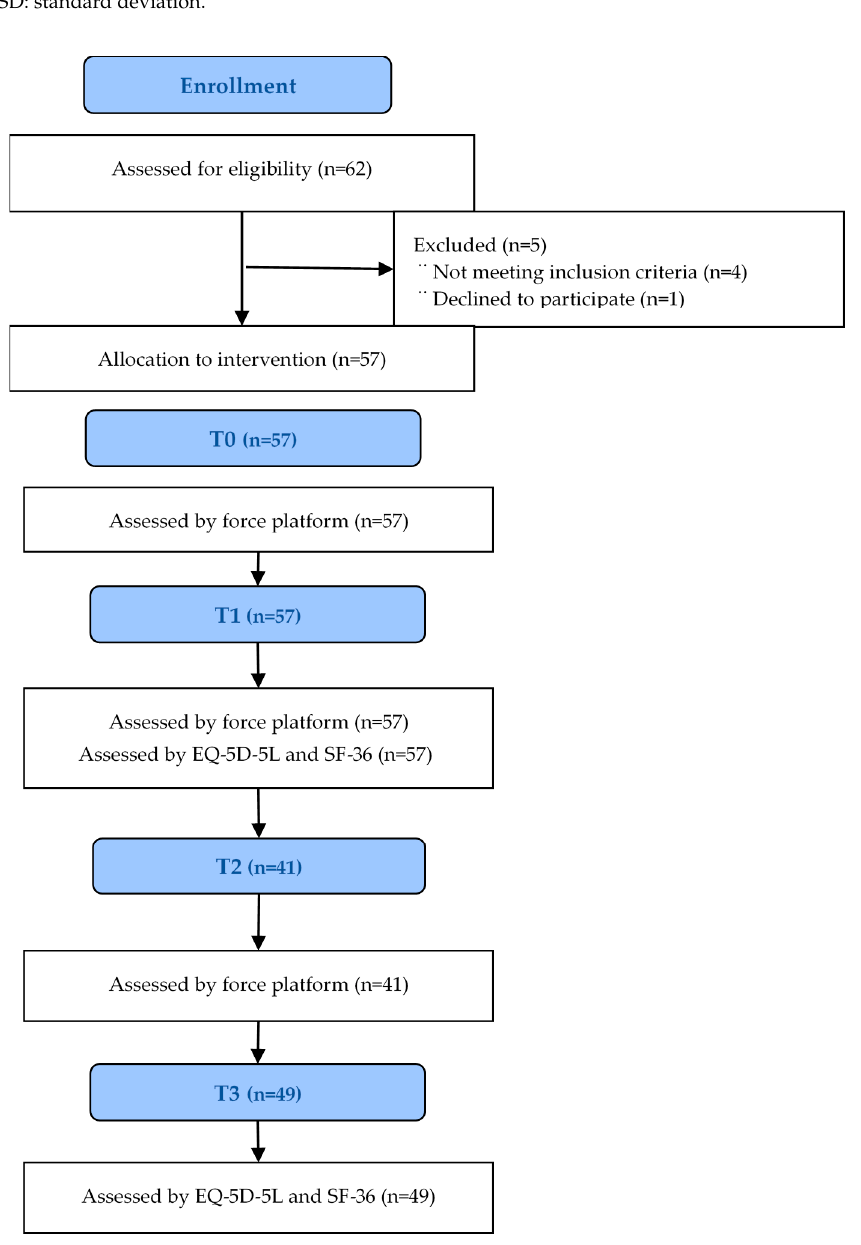
Figure 4. Flow Chart of the study.